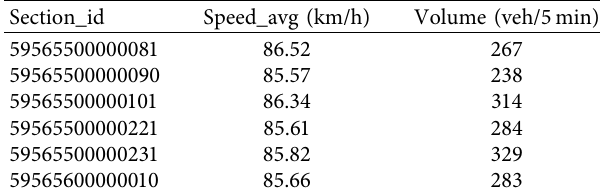
Table 1: Format of raw traffic flow data.